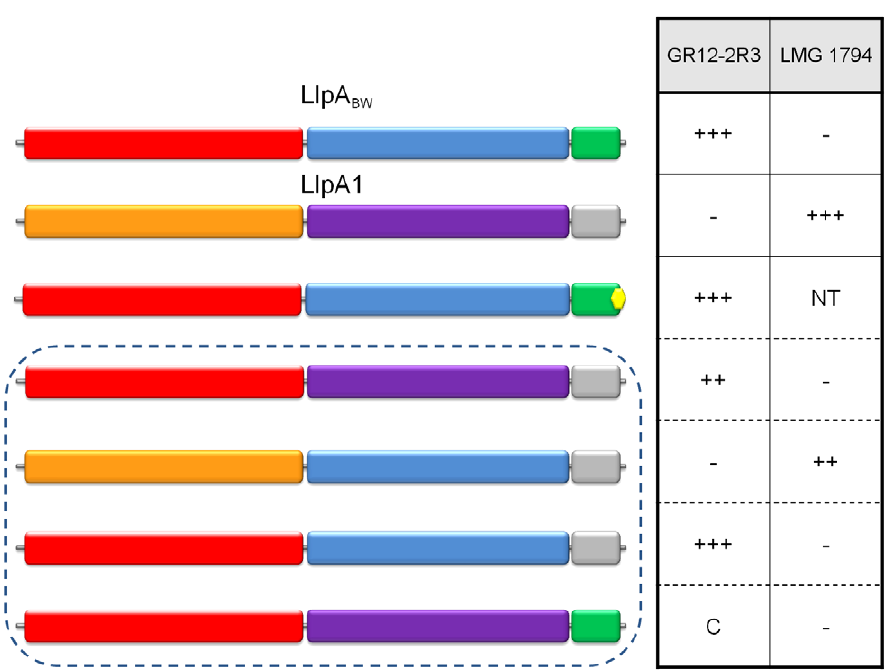
Figure 7. Differential inhibitory activity of wild-type LlpA BW and LlpA/LlpA1 domain chimers. The domain structures of LlpA BW (as in Figure 4) and of LlpA1 (inferred by pairwise alignment; N-domain in orange, C-domain in purple and C-terminal extension in grey) are depicted, along with those of chimeric forms (in dashed box). The LlpA variant lacking the terminal phenylalanine residue is marked with a yellow hexagon. Inhibitory activity of the respective E. coli recombinants was tested with diagnostic indicators for LlpA BW ( P. syringae GR12-2R3) and LlpA1 ( P. fluorescens LMG 1794). Halo sizes are semi-quantified according to size of the growth inhibition halo ( +++ , native halo size of LlpA BW and LlpA1; ++ , halo size reduced; C, local clearing confined to producer colony spot; 2 , no halo or clearing; NT, not tested). Additional chimeric and domain deletion constructs not conferring bacteriocin activity against one of the indicator strains are specified in Figure S11.